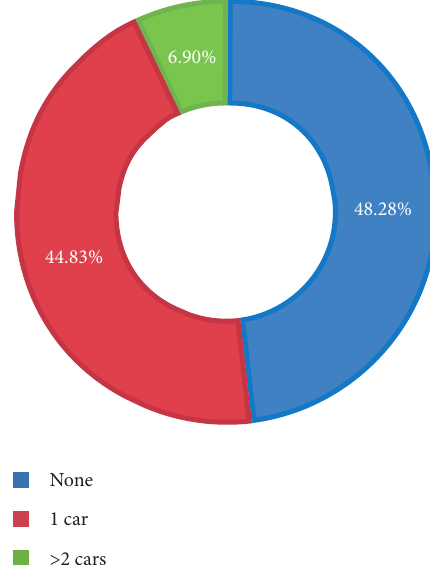
Figure 3: Distribution of car ownership among respondents’ families.